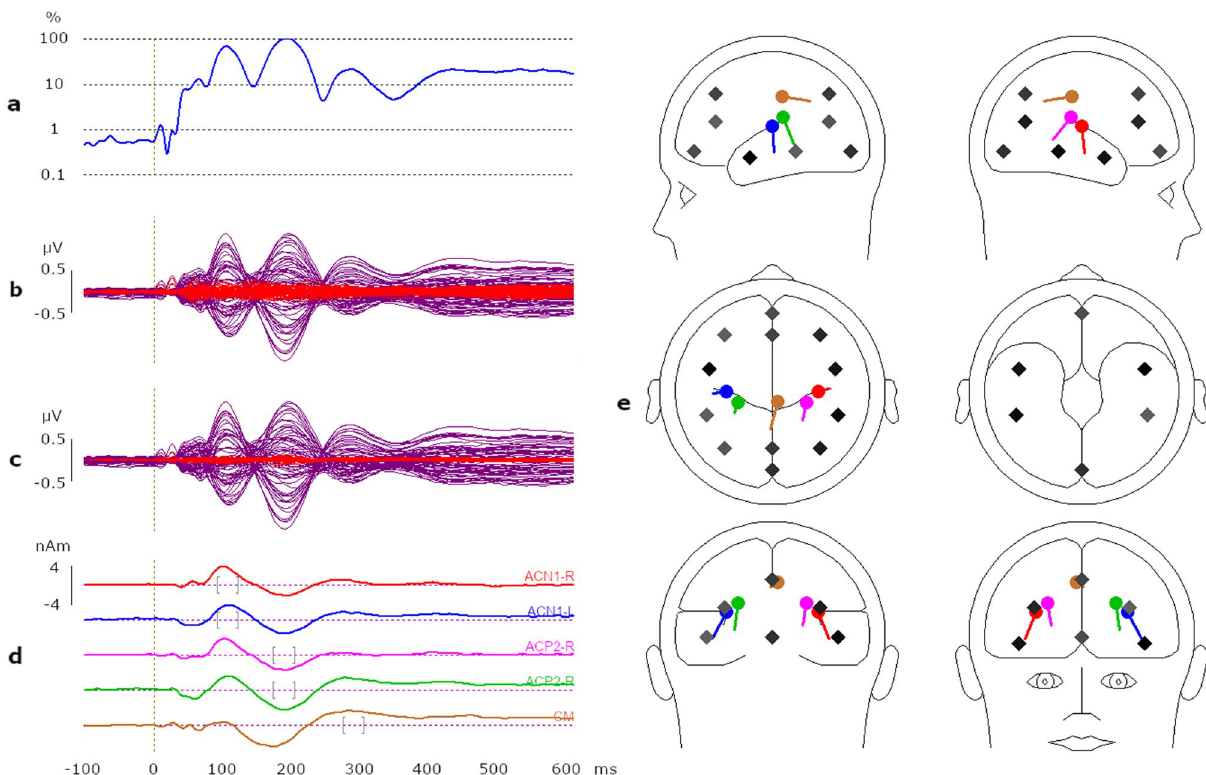
Figure 2. Source Localization Model, Five Dipole + BR regional Sources. ( a ) Illustrates the three GFP peaks consistent with the PCA components in response to the complete data set ( b ) displays the overlay of the five-dipole model (purple) and residual variance (red) and ( c ) illustrates the final five-dipole model + BR regional sources (purple). Notice that the model waveforms (purple) remain similar for both models, but the residual variance (red) is reduced in the final model shown in ( c ). ( d ) Illustrates SWFs obtained at the three- time intervals, 90–120 ms, 170–200 ms and 270–300 ms, consistent with the PCA peaks ( e ) illustrates the five localized source dipoles (red ACN1-R, blue ACN1-L, pink ACP2-R, green ACP2-L) plus the added BR regional sources (BESA 7.1 Research). See text for detail. GFP global field power, PCA principal component analysis, SWFs source waveforms, BR brain